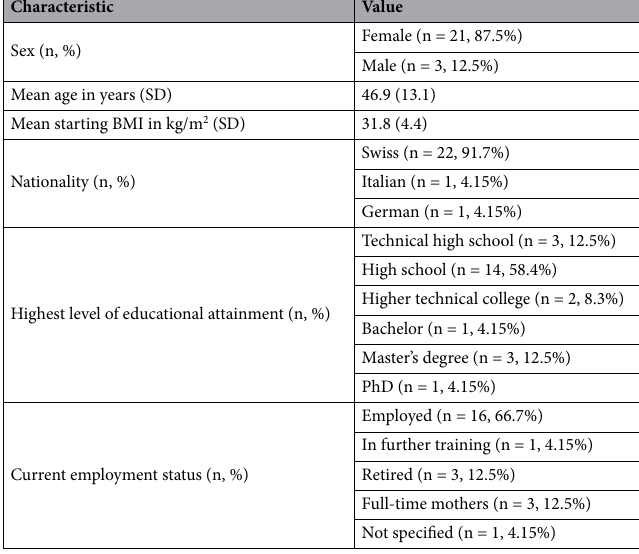
Table 3. Participants’ demographics (n = 24).